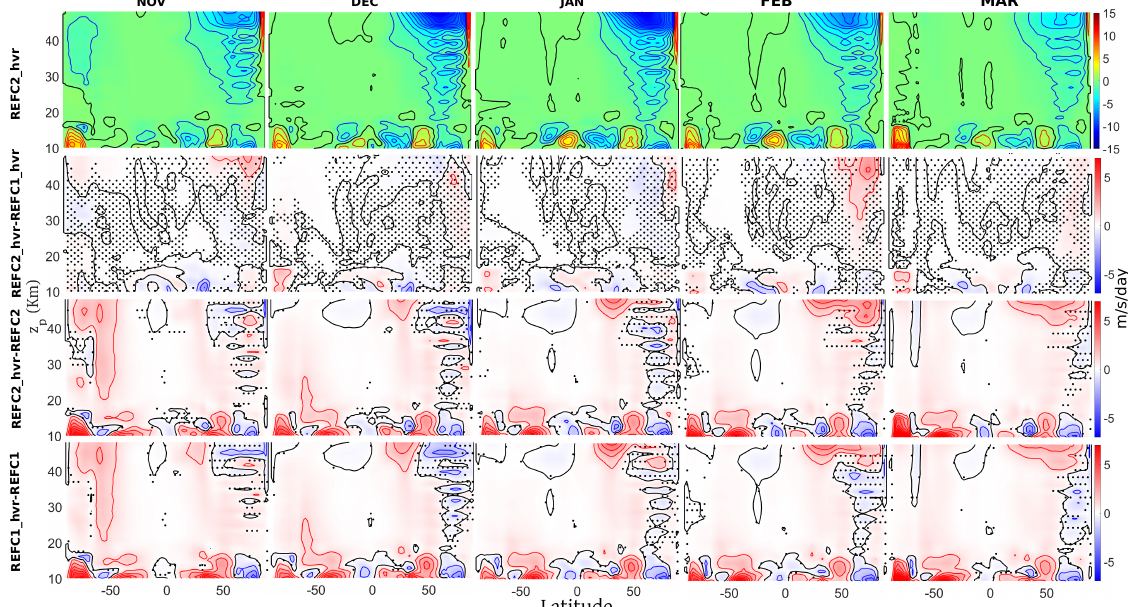
Figure 6. Monthly climatology in EPFD and the differences between simulations. Climatological EPFD of WACCM simulations for November to March (from left to right). Contour lines are at intervals of 1 m/s/day. The statistical significance of the differences was computed by a Student’s t -test and regions with p > 0.05 are stippled